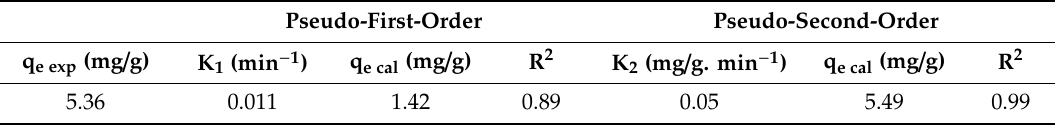
Table 3. Parameters for pseudo-first and second-order reaction kinetics